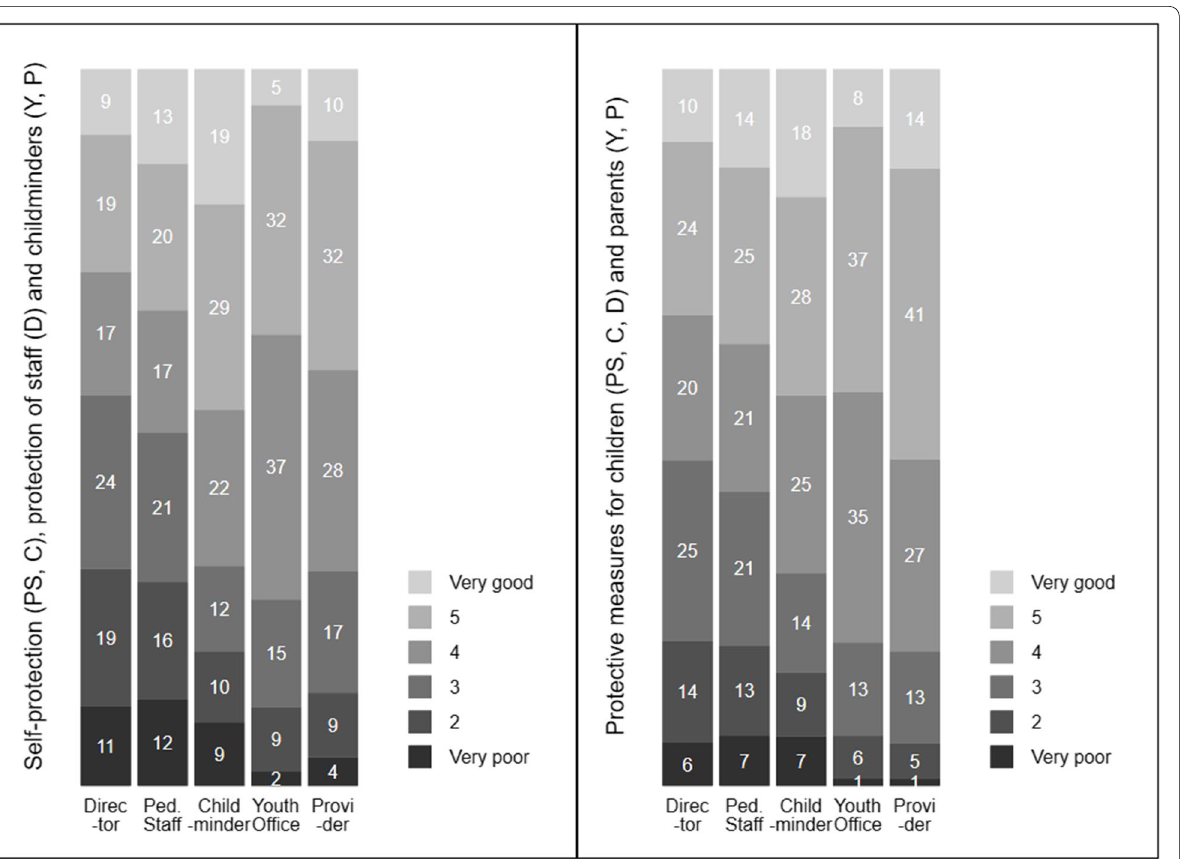
Fig. 1 Directors’ subjective level of informedness on protection of ECEC staff and protective measures for children compared to information given by the other four ERiK target populations. Legend: as reported by directors (D), pedagogical staff (PS), childminders (C), youth offices (Y) and providers (P), ERiK-Surveys 2020, weighted